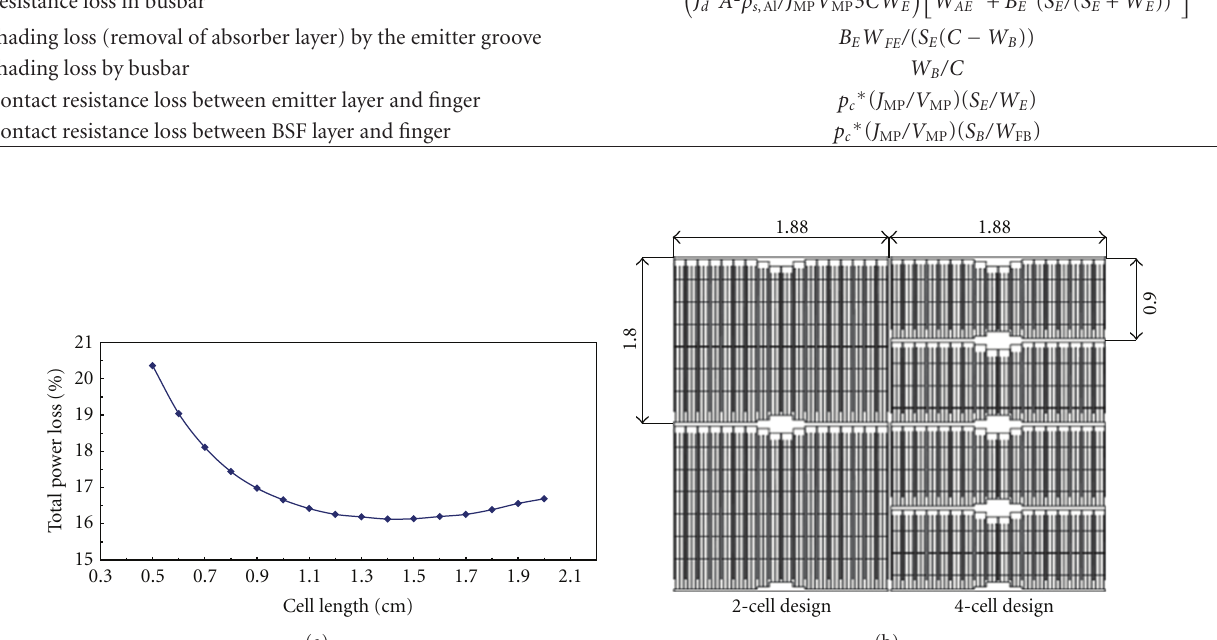
Figure 4: (a) Total power loss (%) as a function of cell length from 0.5 to 2cm when all other parameters such as busbar and finger width are fixed. (b) A metallisation design that patterns the emitter, BSF fingers, and busbar (units in